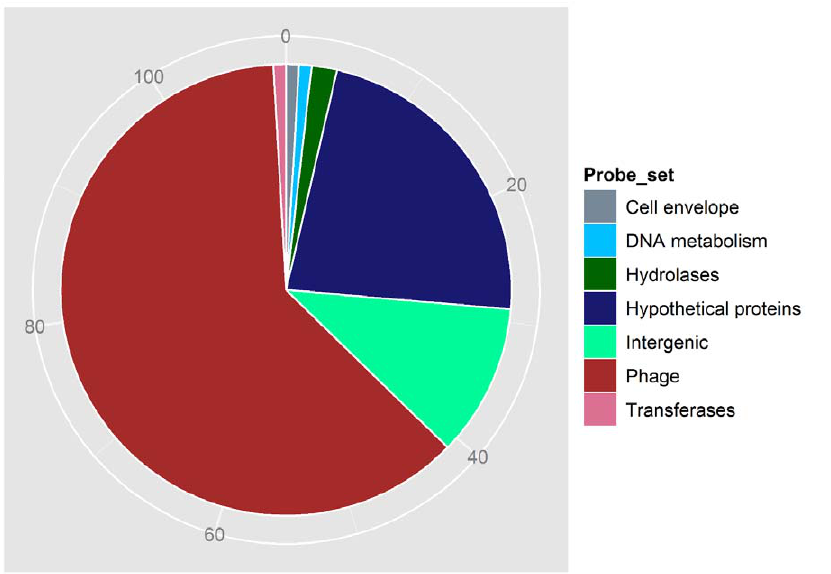
Figure 8. Diagrammatic representation of the distribution of unique probe-sets of the serotype 1/2a, PFGE pattern combination IV 2011 and absent in the PFGE pattern combination I and III strains based on their functions. The numbers of probe-sets were indicated in the periphery of the pie-chart.